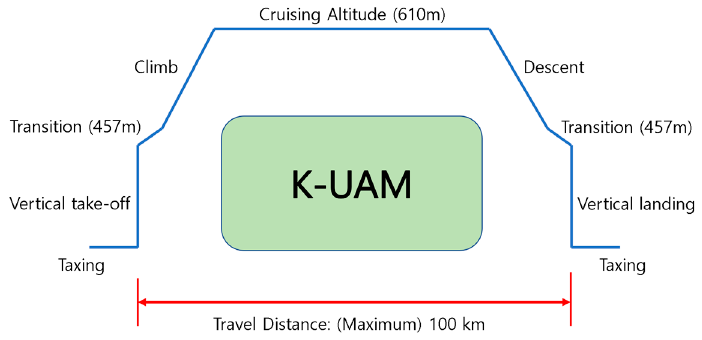
Figure 11. K-UAM mission profile.